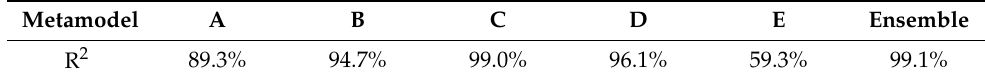
Table 1. Coefficient of determination for analyzed metamodels.